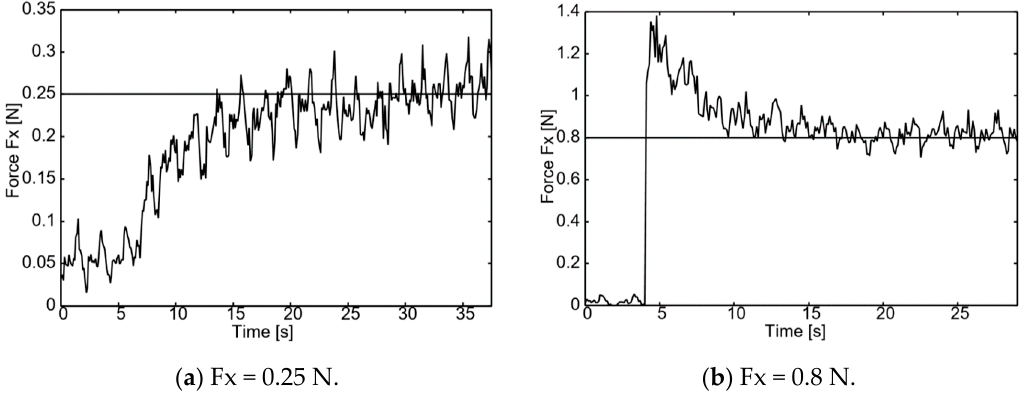
Figure 8. Measured and desired force Fx (0.25 and 0.8 N, respectively). ( a ) Fx = 0.25 N; ( b ) Fx = 0.8 N.